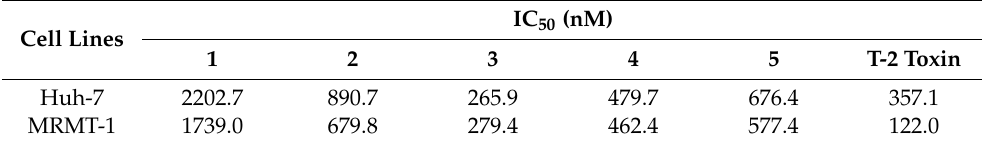
Table 2. Anti-tumor activities of compounds 1 – 5 .